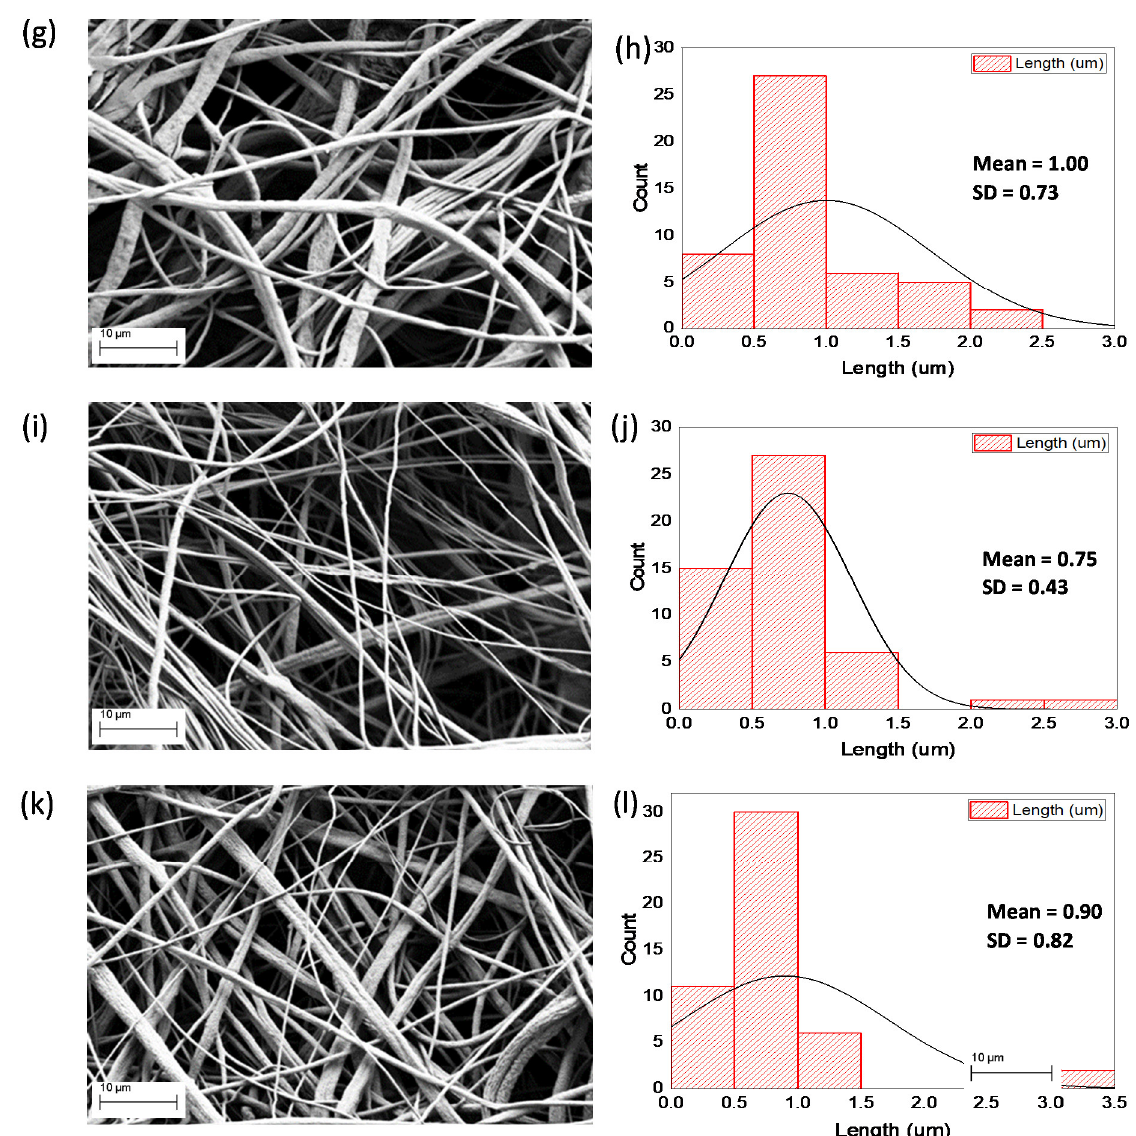
Figure 3. SEM morphology and corresponding histograms showing fiber diameter lengths of ( a , b ) PVDF fiber, ( c , d ) PVDF- 1.25% ZGO, ( e , f ) PVDF-2.5% ZGO, ( g , h ) PVDF-3.75% ZGO, ( i , j ) PVDF-5% ZGO, and ( k , l ) PVDF-10% ZGO.